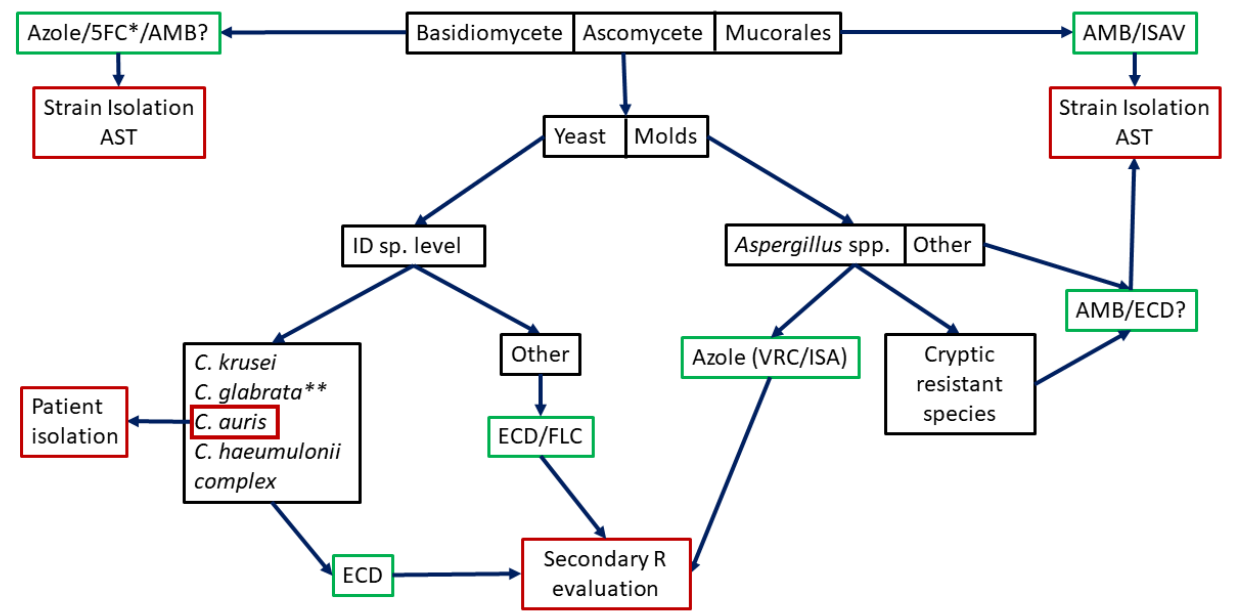
Figure 1. Potential algorithm for intrinsic resistance studies. Black boxes indicate where potential molecular methods would be used (most not designed yet). Green boxes indicate used empirical treatments. Red boxes indicate needed actions (patient isolation if C. auris is identified, the need of secondary resistance evaluation or the strain isolation and AST). 5FC: 5-fluorocytosine, AMB: amphotericin B, ISAV: isavuconazole, ID: Identification, ECD: echinocandins, FLC: fluconazole, VRC: voriconazole. * Combined with AMB for Cryptococcus spp. ** FLC Susceptible Dose-Dependent/Resistant.